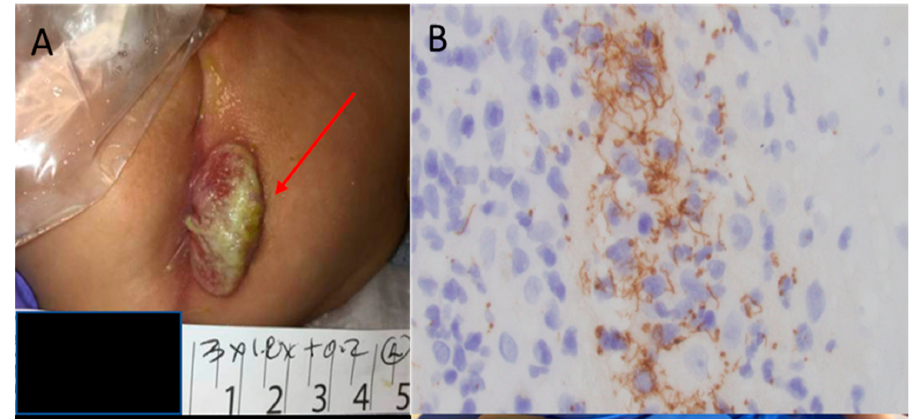
Table 1. Clinical manifestations of early and late congenital